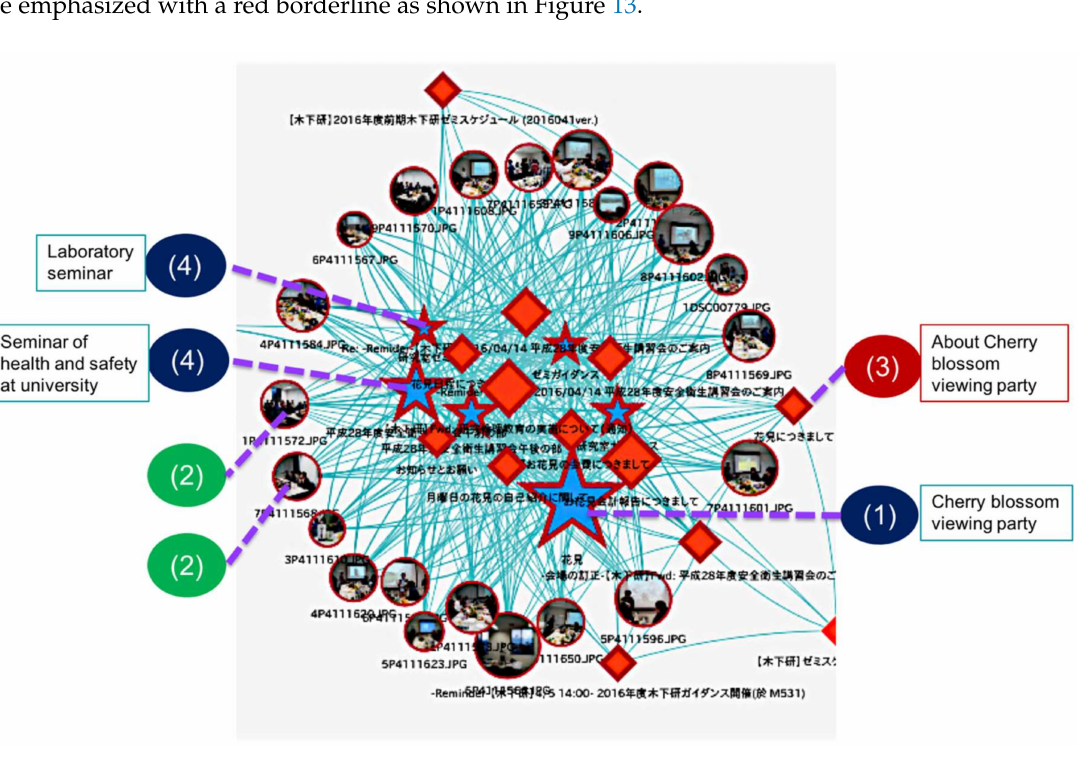
Figure 13. The results of a recall request for “cherry blossom viewing